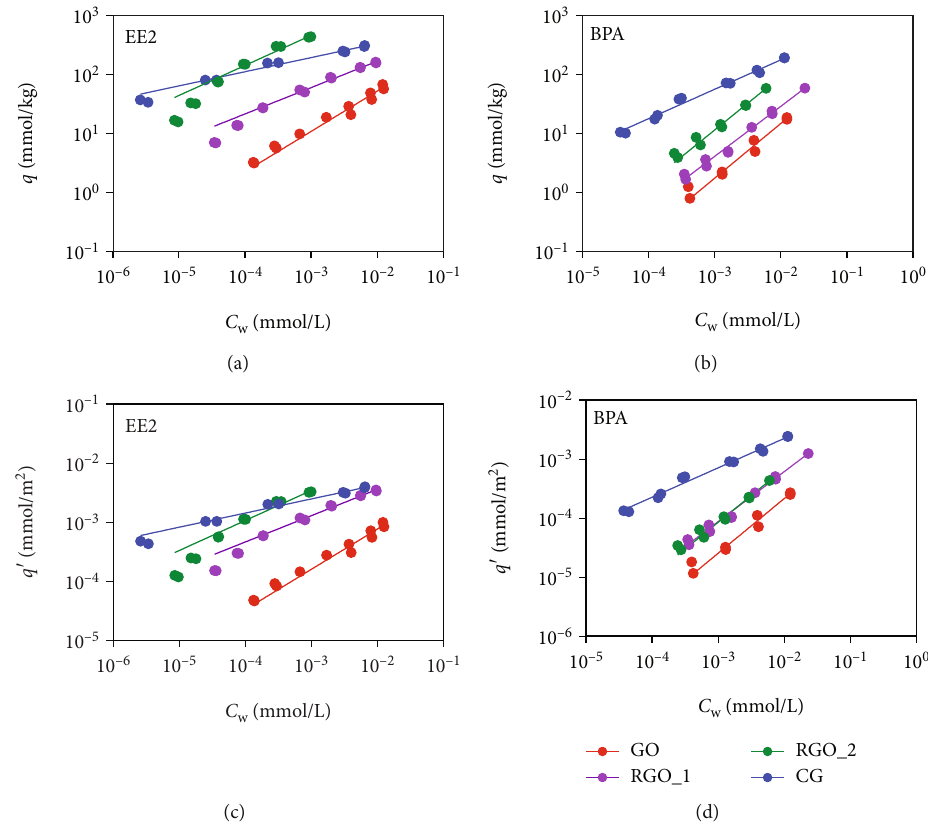
Figure 3: Adsorption isotherms of EE2 and BPA to GMs (a, b) and those normalized by BET surface area (c, d). Table 2: Summary of adsorption parameters [Freundlich model coe ffi cients ( K adsorption